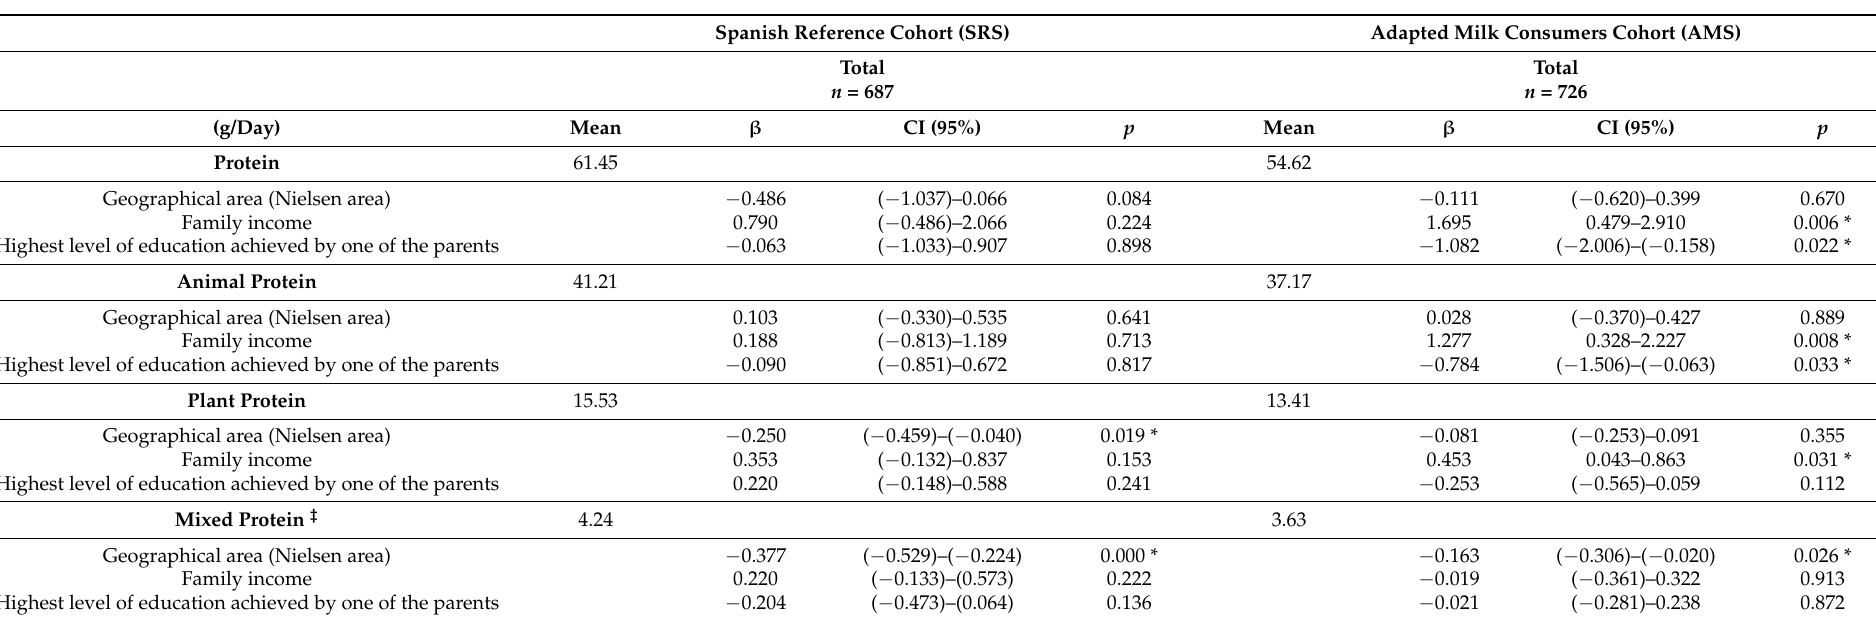
Table 4. Relationship between total protein intake and socioeconomic variables in the two cohorts of the Nutritional Study in the Spanish Pediatric Population (EsNuPI) ( n =